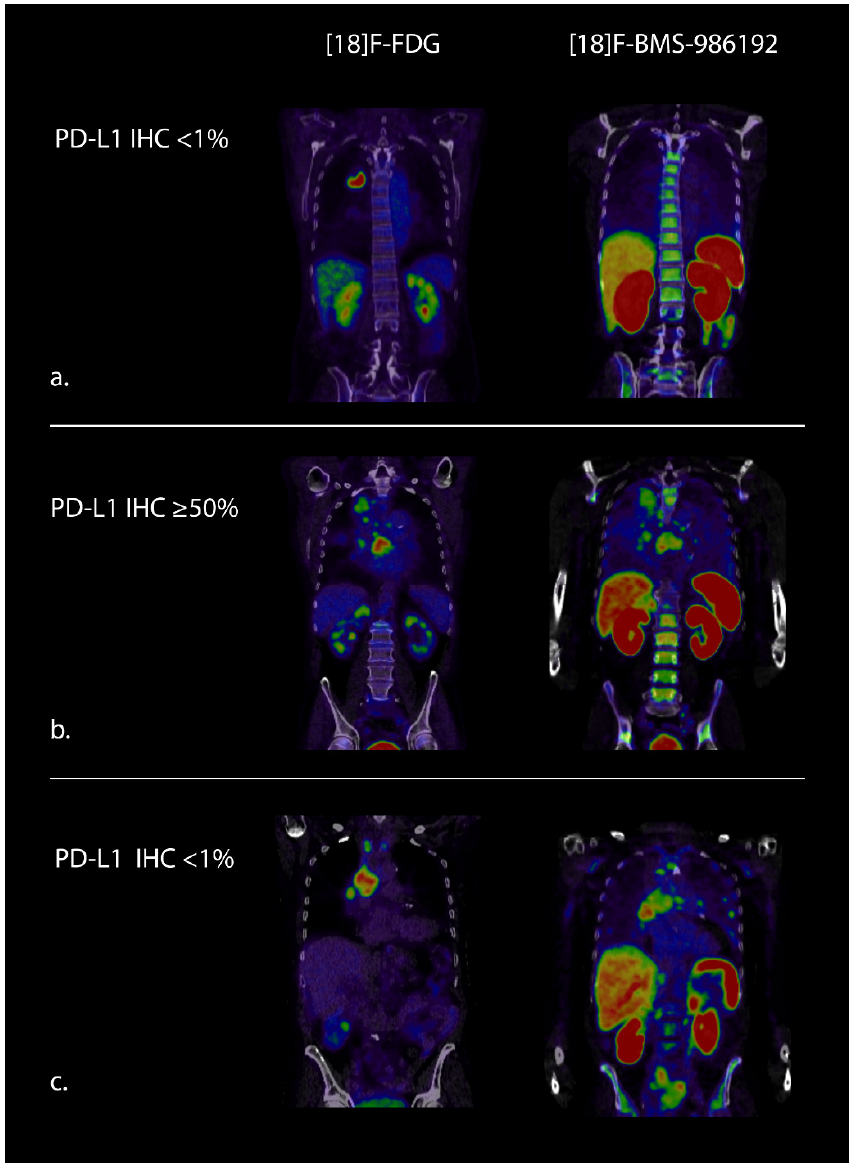
Figure 1. 18 F-FDG-PET and 18 F-BMS-986192 PET (PD-L1 directed tracer) images of ( a ) a patient without PD-L1 expression and no tracer uptake in the tumor on the PD-L1 PET. ( b ) A patient with high PD-L1 expression and high tracer uptake in the tumor on the PD-L1 PET and ( c ) a patient without PD-L1 expression according to IHC, but tracer uptake in tumor lesions on the PD-L1 PET. These examples demonstrate that imaging results correspond with IHC ( a , b ) but can also reveal possible sampling error or tumor heterogeneity ( c ). These images were obtained in our institution as part of the NCT03564197 trial.